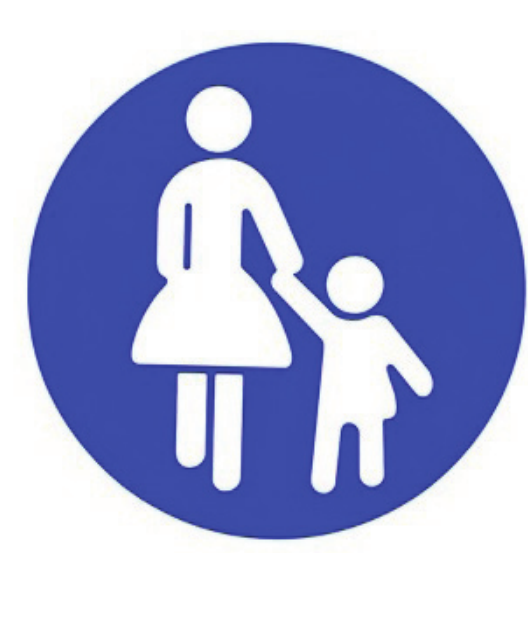
Figures 23, 24. Book cover from 2003: Woman’s Life Without Children: The Intentional Decision Against the Mother Role, by permission of Weiss Werkstatt, München, and pedestrian-only